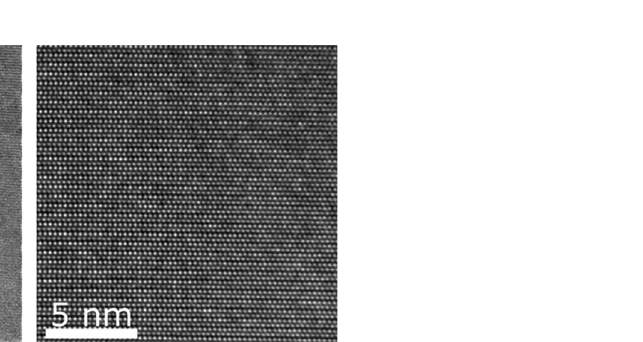
Figure 4. Comparison of the HRXRD 2theta/omega scans for the GaN:Si layers prior (black line) and after (red line) He-ion implanatation.